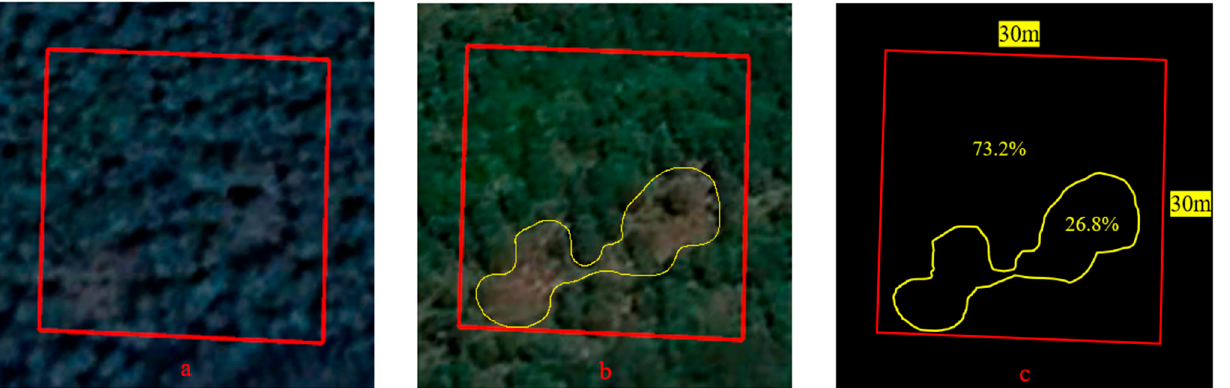
Figure 3. Visual interpretation methods for affected forest area and calculation of damage severity based on Google Earth Pro high-resolution images. ( a ): high-resolution images before Typhoon Rammasun; ( b ): after Typhoon Rammasun; ( c ): methods for calculating forest canopy loss rates.